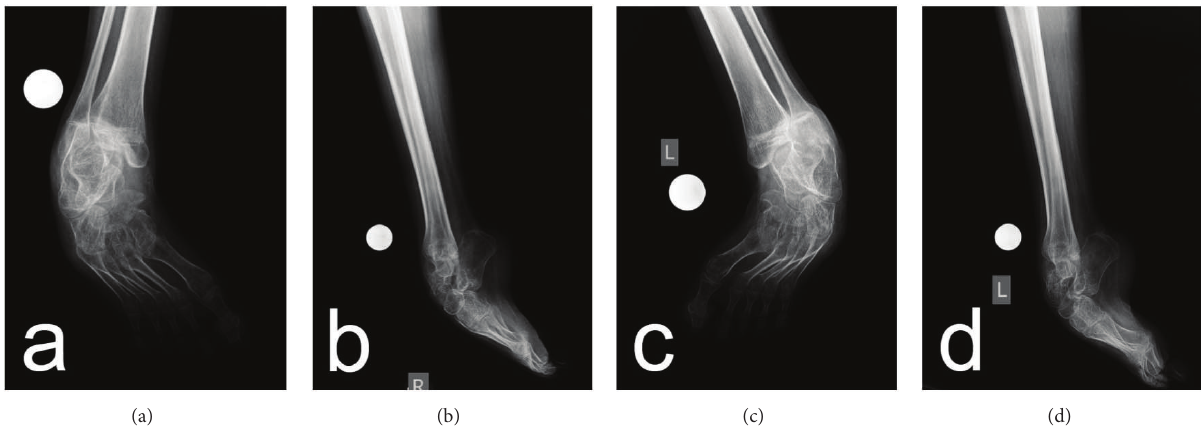
Figure 2: Preoperative anteroposterior (a, c) and lateral (b, d) radiographs of the patients with hereditary motor and sensory neuropathy type I.